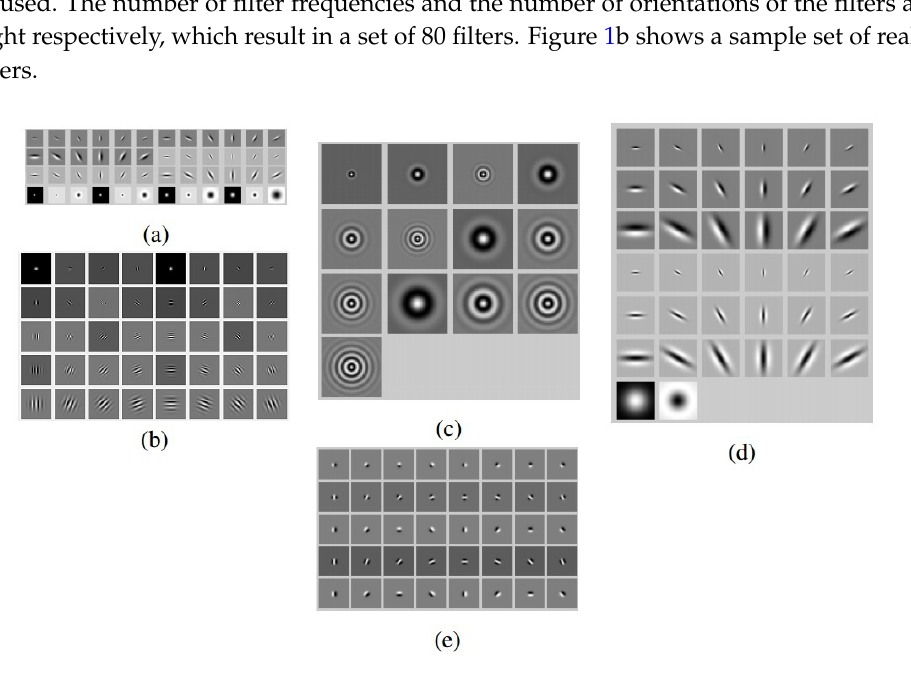
Figure 1. Samples of the filter banks used for creating the dense descriptors: ( a ) Leung–Malik (LM), ( b ) the real part of the Gabor (G), ( c ) Schmid (S), ( d ) Root Filter Set (RFS) and ( e ) Steerable (St)